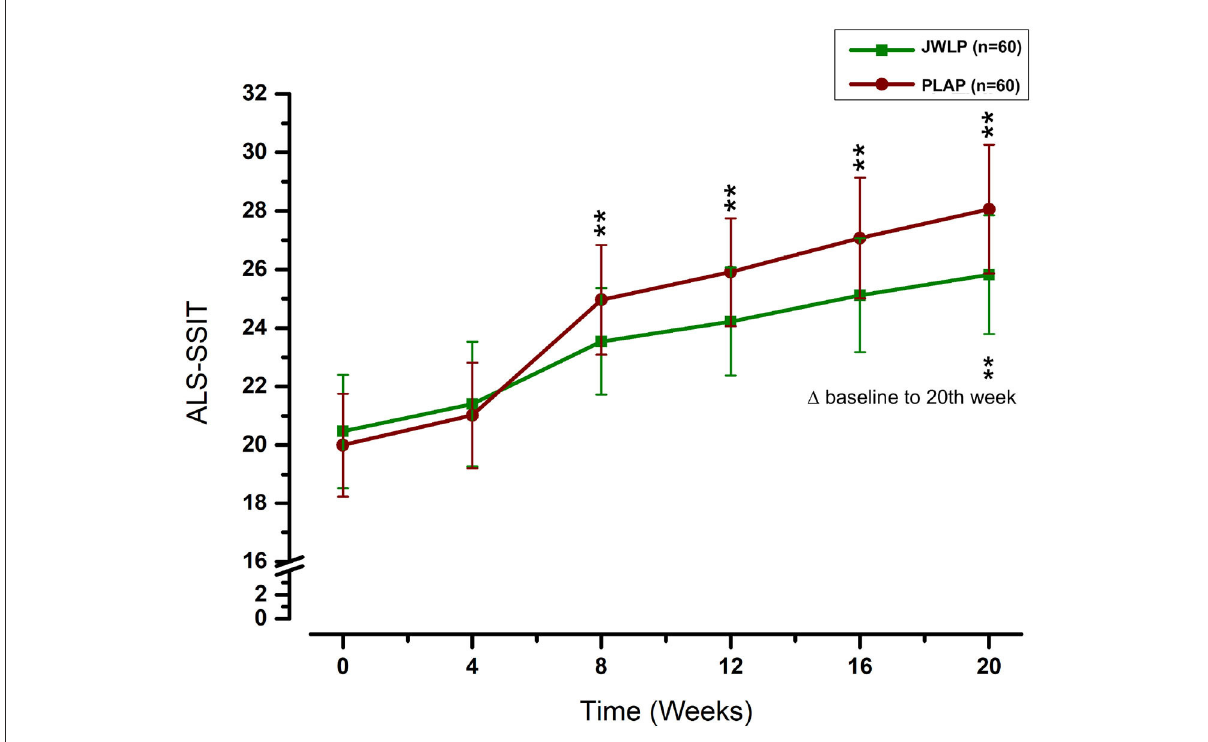
FIGURE5 Change over time in the ALS-SITT over the 20 week trial period. ** p < 0.01.